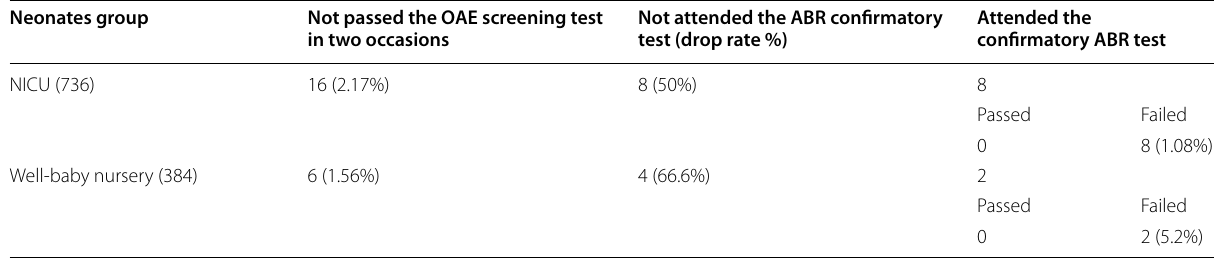
Table 3 Results of screening and confirmatory hearing tests in the two groups of neonates studied Neonates